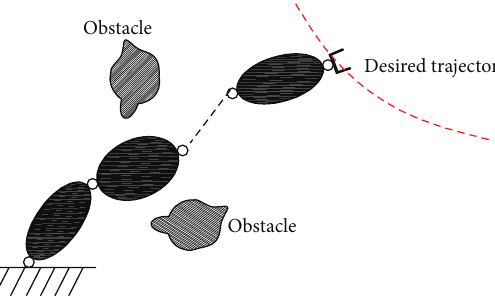
Figure 3: The obstacles do not disturb the motion of the end- effector.